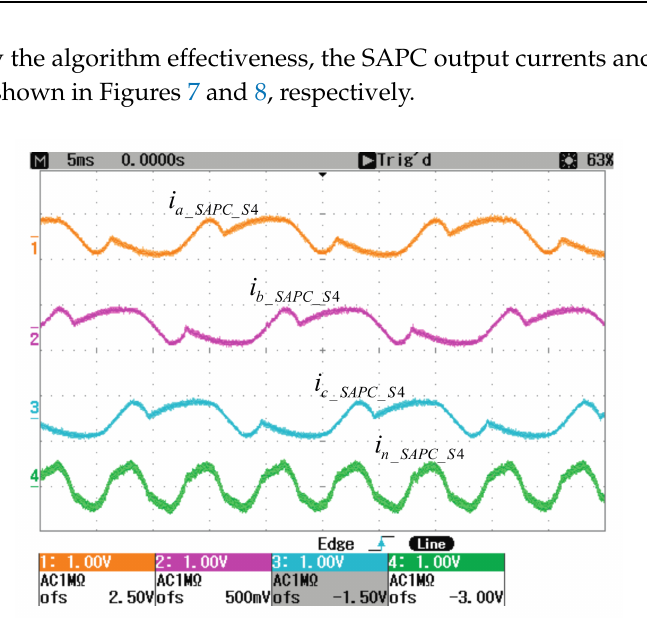
Figure 7. SAPC output currents for the CS4 sequence.